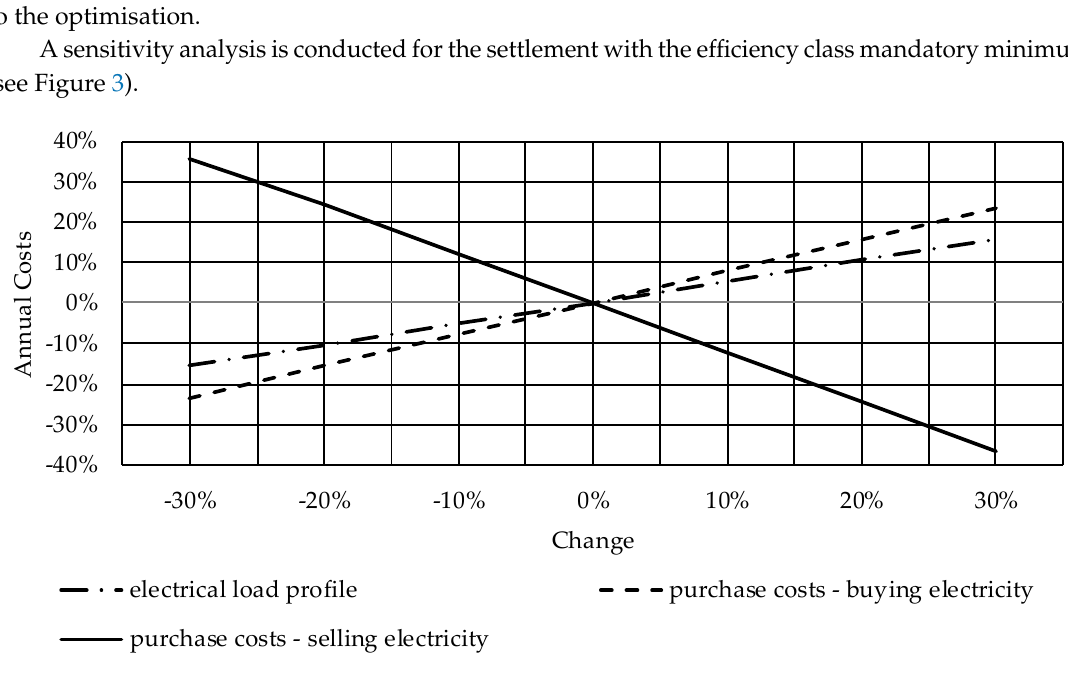
Figure 3. Sensitivity analysis for the settlement with buildings of efficiency class mandatory minimum.